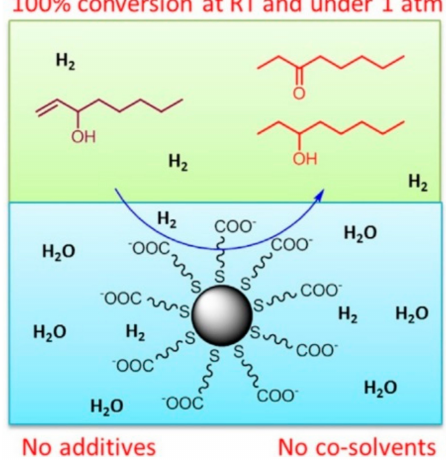
Figure 3. Biphasic catalytic reaction of hydrophobic allylic alcohols in water (5–10 mol % Pd/substrate, 50 µ L substrate in 3 mL water or PBS buffer pH 7.4 solution, 1 atm H 2 ). Reproduced from Ref. [72] with permission from the ELSEVIER,